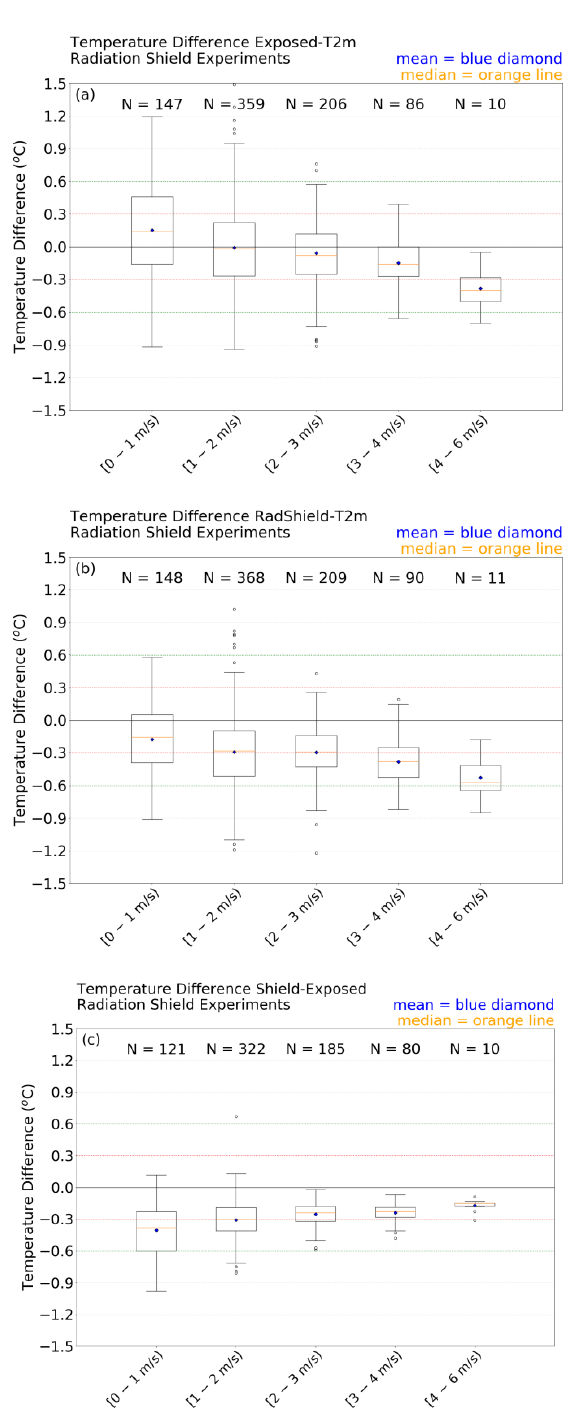
Figure 12. Side-by-side boxplot by 2 m wind speed bins (m s −1 , labeled on x-axis) of temperature difference (°C) between between ( a ) the exposed iMET-XQ sensor and HMP-45C (T exposed − T 2m ); ( b ) the shielded iMET-XQ sensor and HMP-45C (T shielded − T 2m ); and ( c ) the shielded and exposed iMET-XQ sensors (T shielded − T exposed ). Sample size (N) for each bin is given above each boxplot. The means are represented by blue diamonds, the medians are shown by orange lines. A temperature difference of ±0.3 °C is marked by a red dotted line. A temperature difference of ±0.6 °C is marked by a green dotted line.